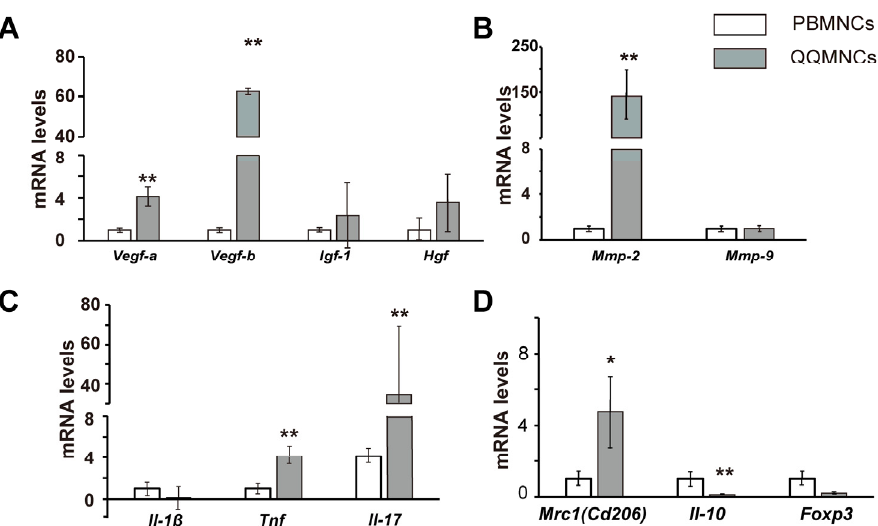
Figure 4. qRT-PCR analysis of PBMNCs and QQMNCs derived from EAM rats. Data are shown as mean ± SE. N = 5 or 6, * p < 0.05, ** p < 0.01 vs. QQMNCs. Enhanced gene expression for vascular regeneration, anti-inflammatory, and cardioprotective effects in a rat model of myocarditis. ( A ) Proangiogenic growth and cardiogenic factors. ( B ) MMPs. ( C ) Inflammatory cytokines. ( D ) Anti-inflammatory cytokines and immune tolerance. Data are shown as mean ± SE. N = 5 or 6 per group. VEGF: vascular endothelial growth factor, HGF: hepatocyte growth factor, IL: interleukin, MRC1: mannose receptor (CD206), Igf-1: insulin-like growth factor 1, Mmp: matrix metalloproteinase, Tnf: tumor necrosis factor.